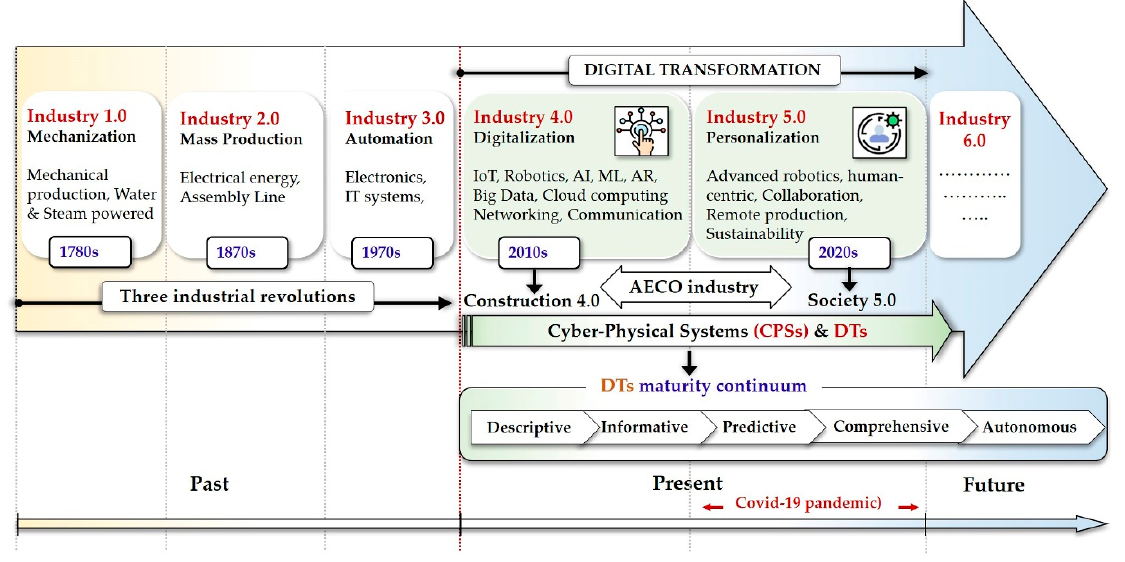
Figure 4. DTs and industrial revolution timeline. Adapted from [42,44].